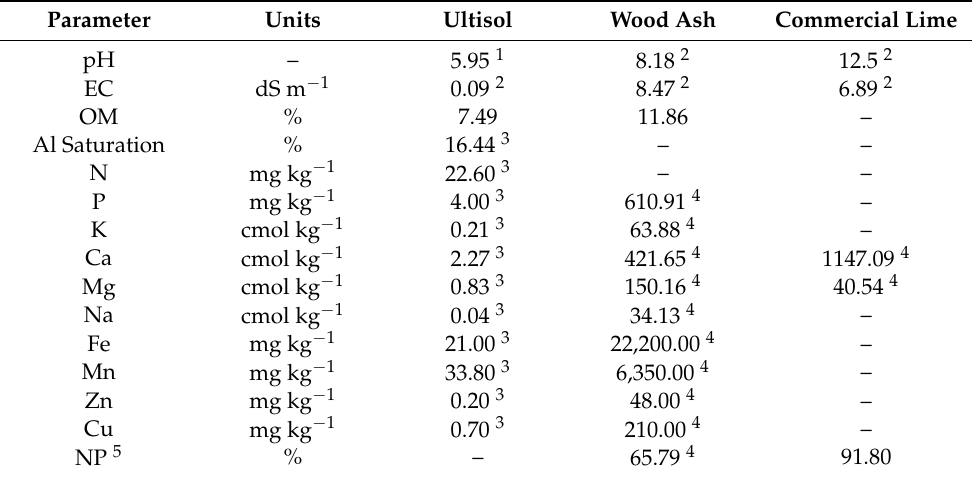
Table 1. Chemical properties of soil, wood ash, and commercial lime.